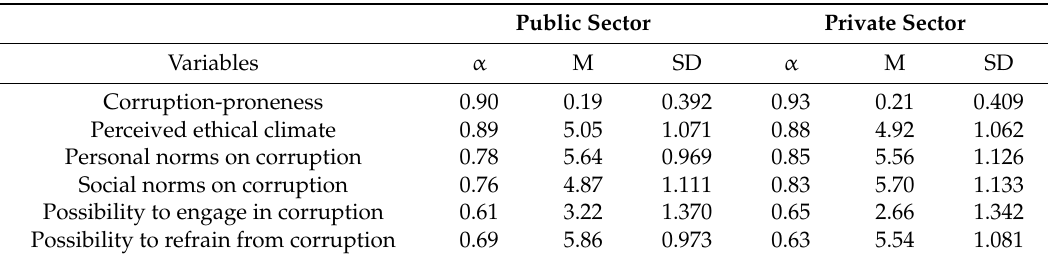
Table 1. Summary statistics, disaggregated for the public sector ( n = 234) and the private sector ( n =